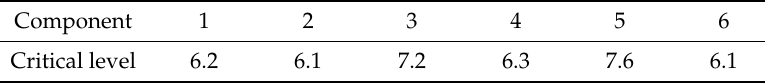
Table 4. Maintenance decision variables under maximum